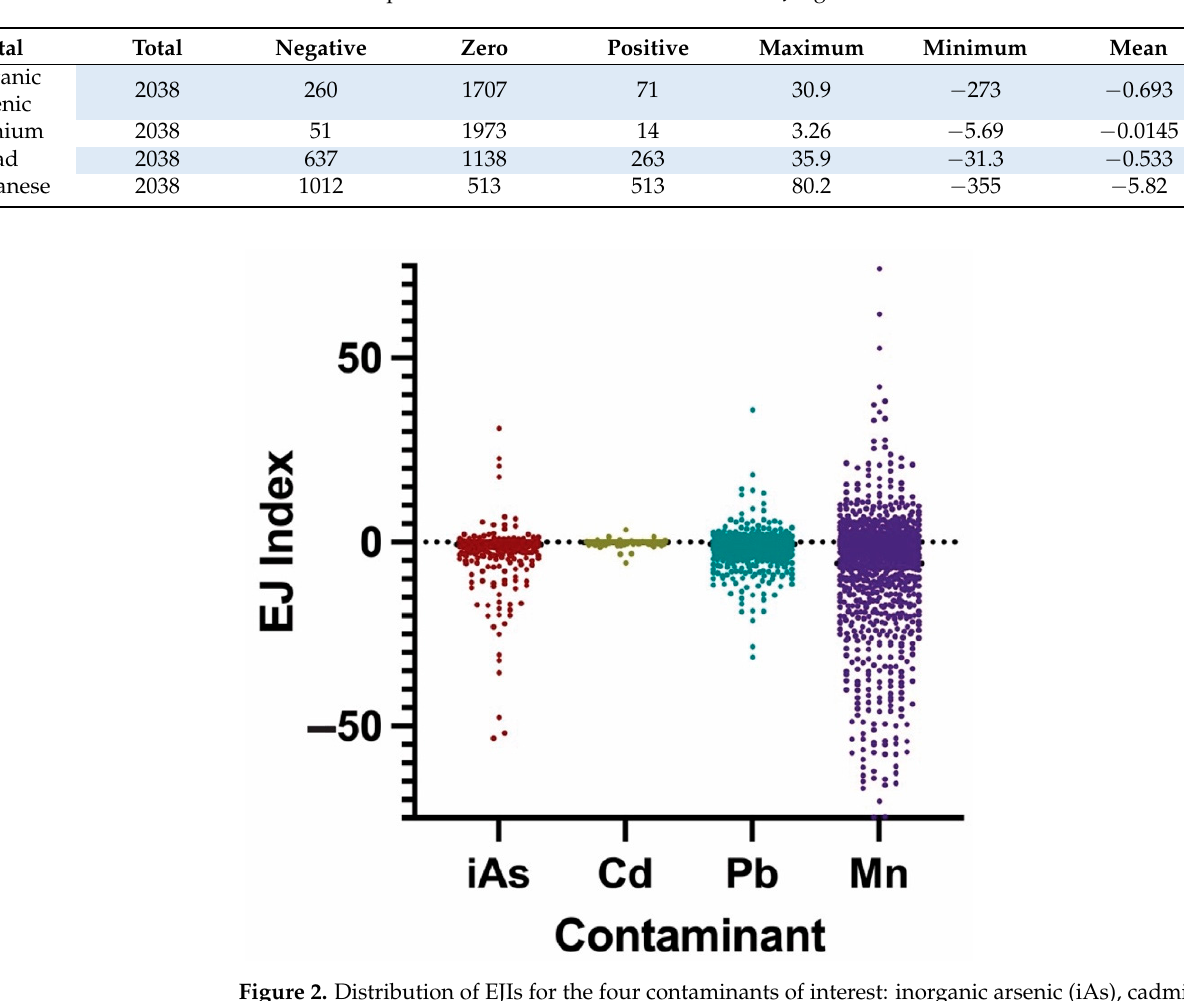
Table 1. Descriptive statistics for each of the four TM-EJIs generated.